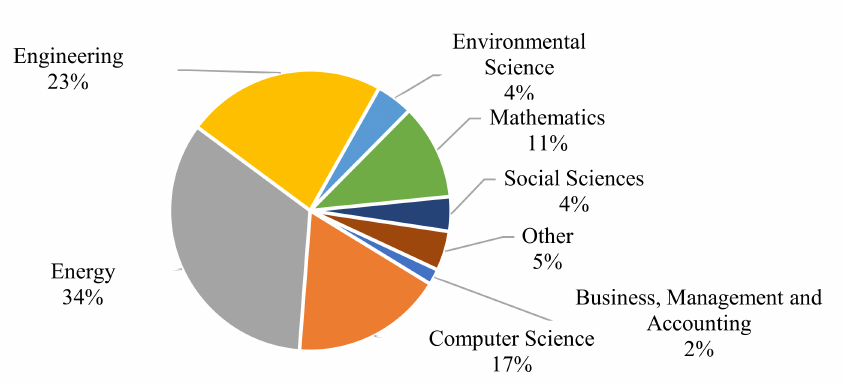
Figure 3. Publications on smart grids evaluations, according to research areas (based on the Scopus database).